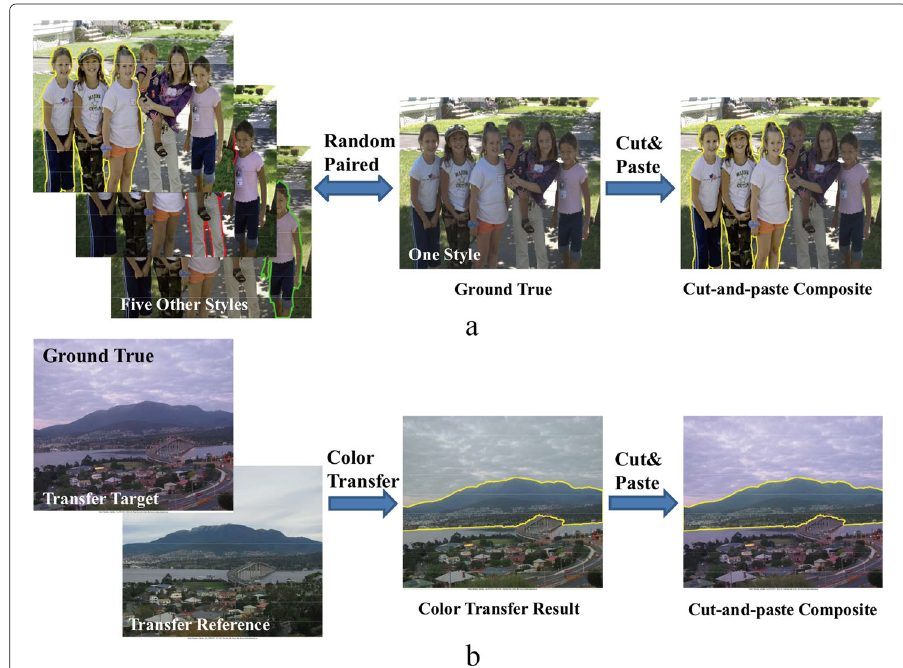
Fig. 3 Data acquisition methods for our multi-scenario dataset. a MIT-Adobe FiveK. b